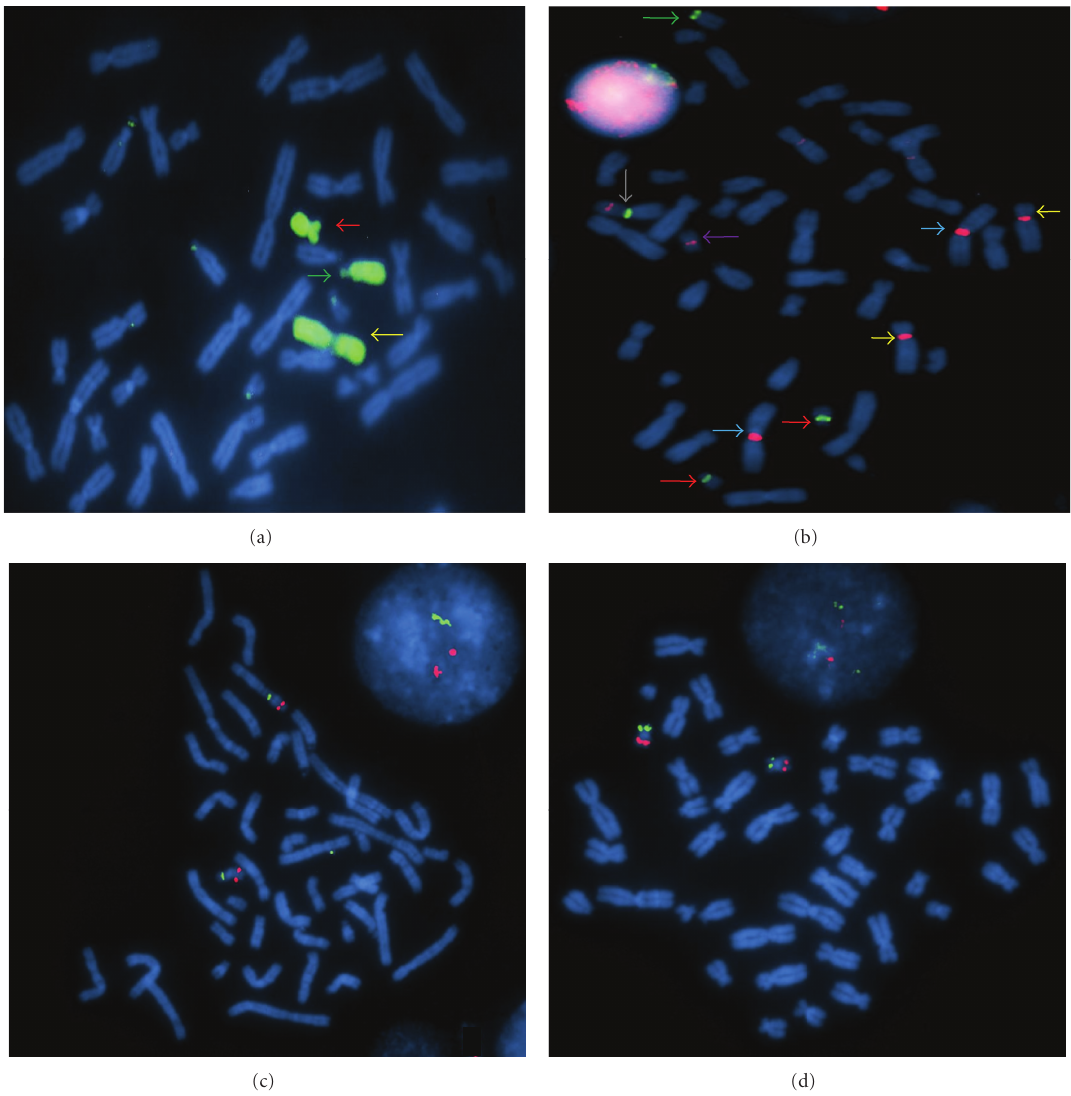
Figure 2: FISH on the lymphocyte metaphase spreads of the patient. (a) WCP FISH with 14 and 19 paints. Green arrow points normal 14, red arrow points the normal 19 and the yellow arrow points the derivative chromosome 14. (b) FISH with SE (14/22) and SE (19/5/1) shows green arrow on normal 14, violet on normal 19 and white arrow shows the dicentric 14. (c) FISH with ZNF443 (19p13) ERCC1 (19q13)/shows the green signals proximal to the dicentric chromosome and red signals towards the distal region. (d) ERCC1 probe on normal metaphases shows both the signals on both the chromosome